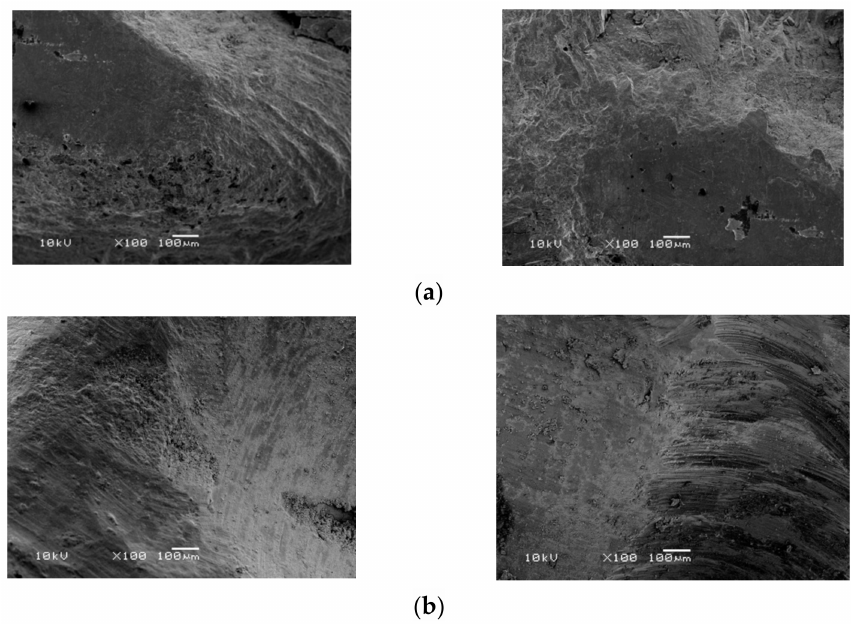
Figure 5. Fractographic analysis under SEM: ( a ) SEM for the porcelain fused to metal sample, ( b ) SEM for the full monolithic zirconia